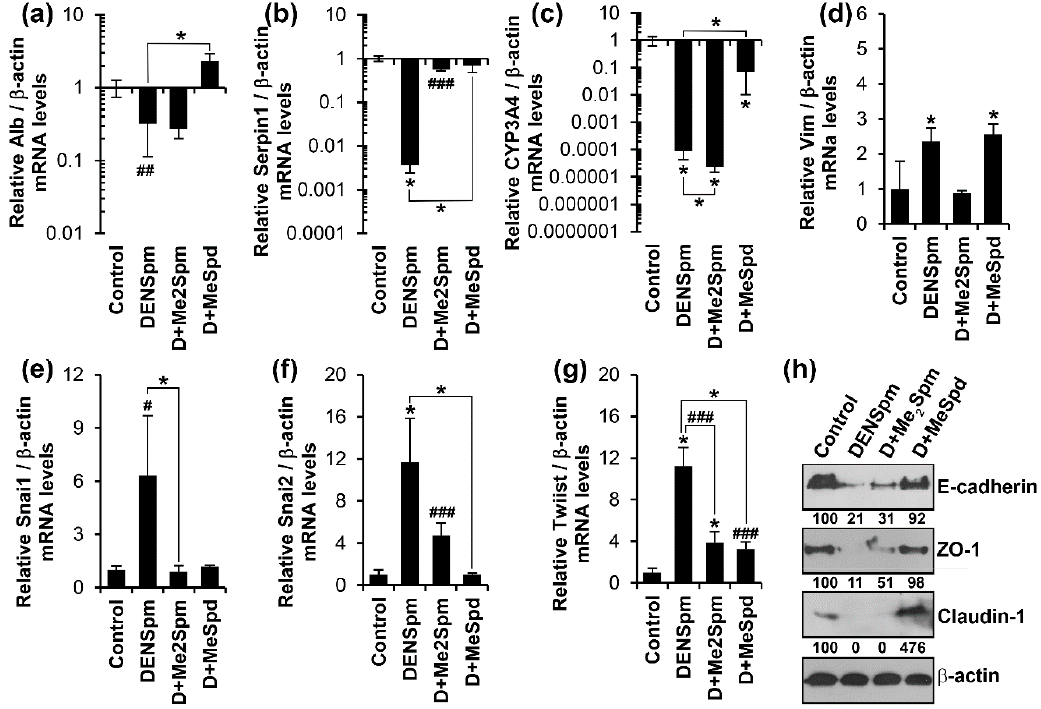
Figure 5. Metabolically-stable 3-methylspermidine and (S,S)-3,10-dimethylspermine prevent DENSpm-driven dedifferentiation of HepaRG cells. Differentiated HepaRG cells were treated for 72 h with 10 μ M DENSpm in the absence or presence of 100 μ M (R)-3-methylspermidine (D+MeSpd) or 100 μ M (R,R)-1,12-dimethylspermine (D+Me2Spm). ( a – g ) Quantification of levels of mRNAs for liver epithelial and mesenchymal cells were performed as described above. The results are presented as means ± S.D. from three independent experiments. * p < 0.05, # p < 0.06, ## p < 0.08, ### p < 0.10 vs. untreated cells (Control) if not state otherwise. ( h ) Expression of claudin-1, E-cadherin and ZO-1 was quantified by western blotting, using β -actin as a house-keeping gene. The values represent protein/ β - actin levels normalized to the control